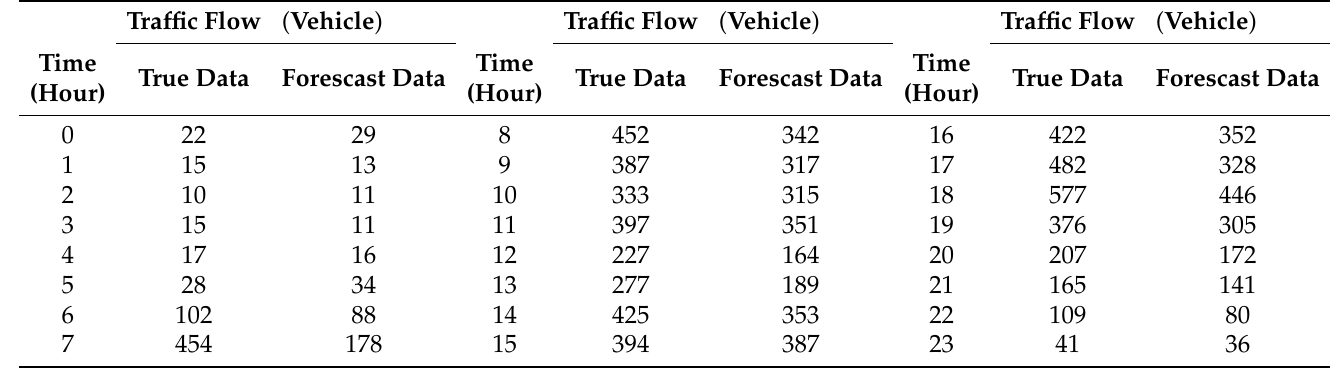
Table 1. The true and forecast traffic data in gate 2.